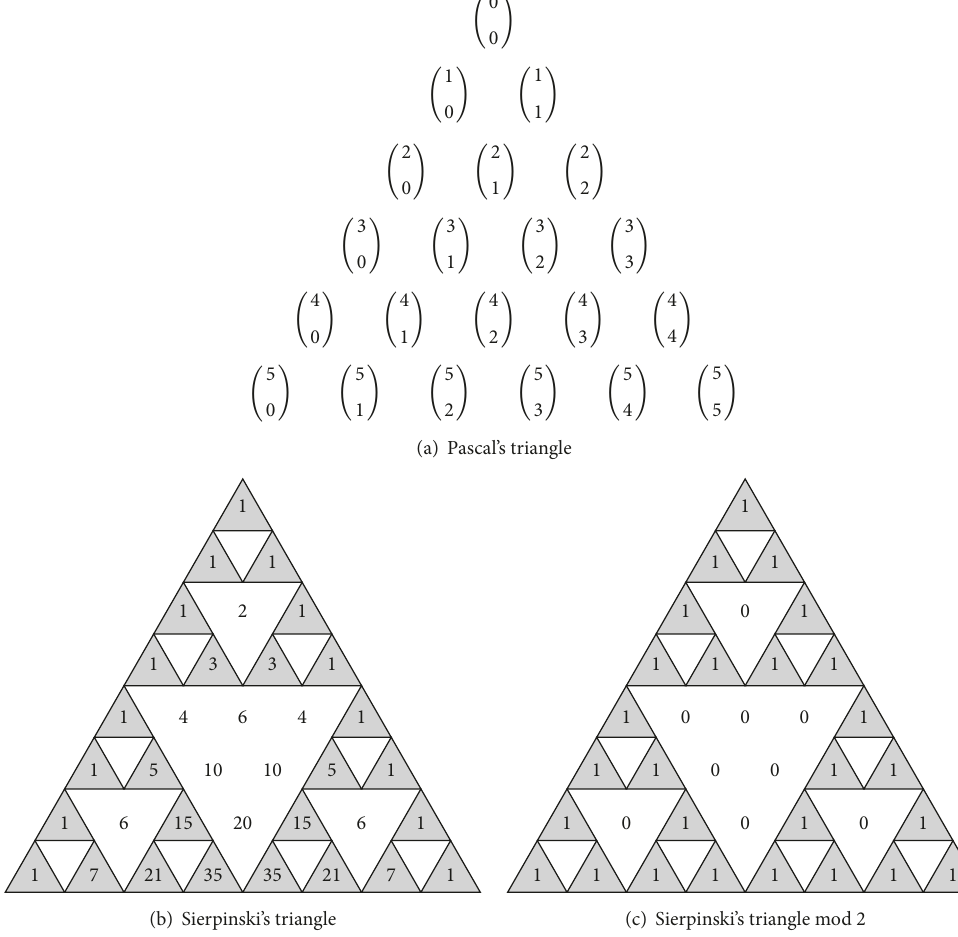
Figure 2: Binomial coefficients arranged as